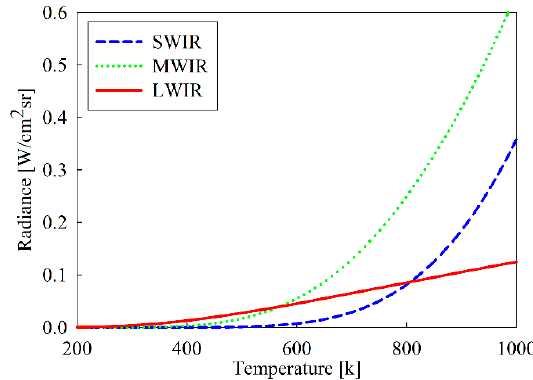
Figure 2. Radiances of three infrared (IR) wavelength bands according to temperature.